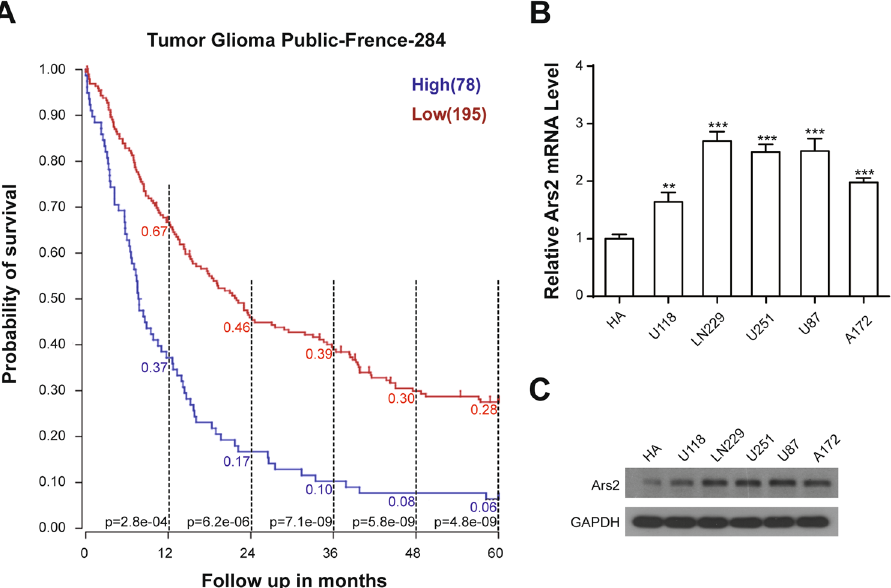
Figure 1. High expression of Ars2 in glioma patients and in glioblastoma cell lines is prognostic of worse survival in glioma patients. ( A ) Kaplan-Meier analysis of progression-free survival for the French database with the log-rank test P value indicated. Cutoff values for separating high and low expressing groups were determined by the online R2 database algorithm. ( B ) Five glioblastoma cell lines (U87, LN229, A172, U118, and U251) and normal human astrocytes (HA) were harvested and subjected to qRT-PCR analysis to detect Ars2 expression. Data were represented as the mean ± SD for three separate experiments, ** P < 0.01; *** P < 0.001. ( C ) The expression of Ars2 in five glioblastoma cell lines and HA was analyzed by Western blot